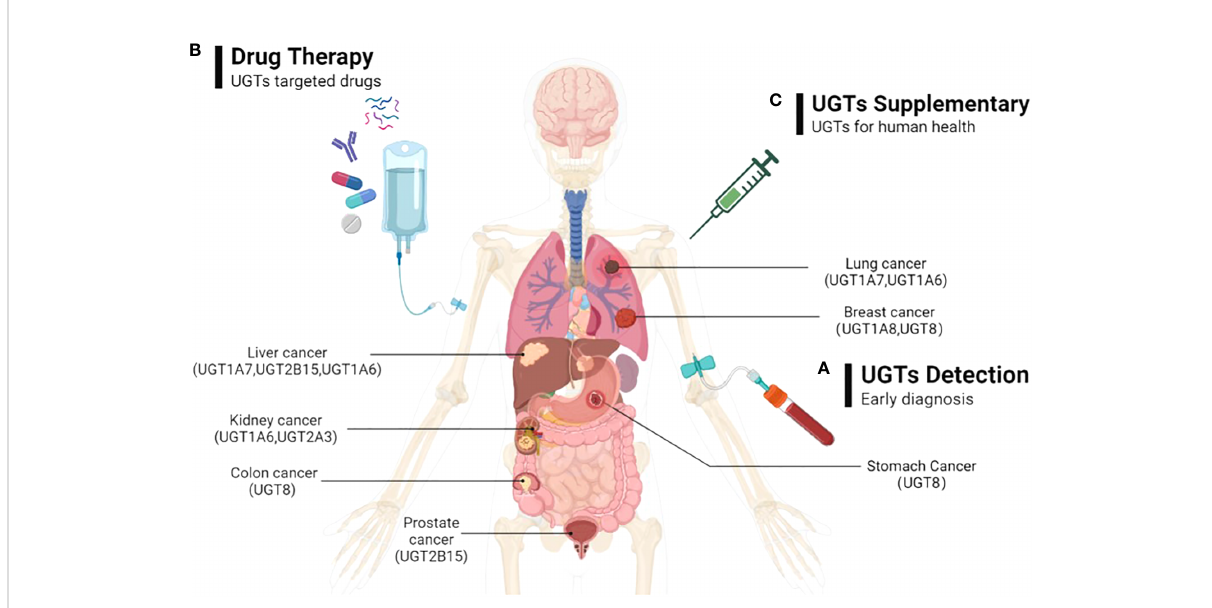
FIGURE 6 The possible directions of UGTs-related cancer therapy prospects. (A) By detecting the expression of UGTs to do early diagnosis of cancer; (B) Through the exploration of bene fi cial and safe UGT-targeted drugs with promising pharmaceutical applications to prevent and therapeutic UGTs-related cancers; (C) By injecting appropriate volumes of UGTs in cancer patients who were de fi cient in UGTs to supplement the de fi cient UGTs in the